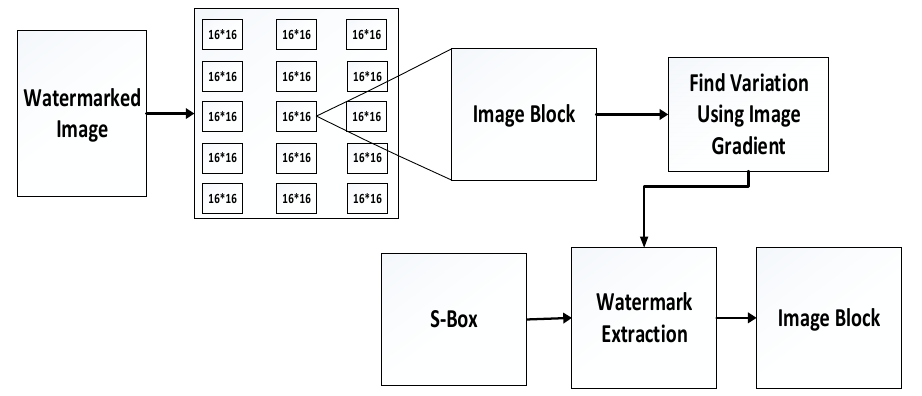
Figure 4. Watermark extraction flow diagram.